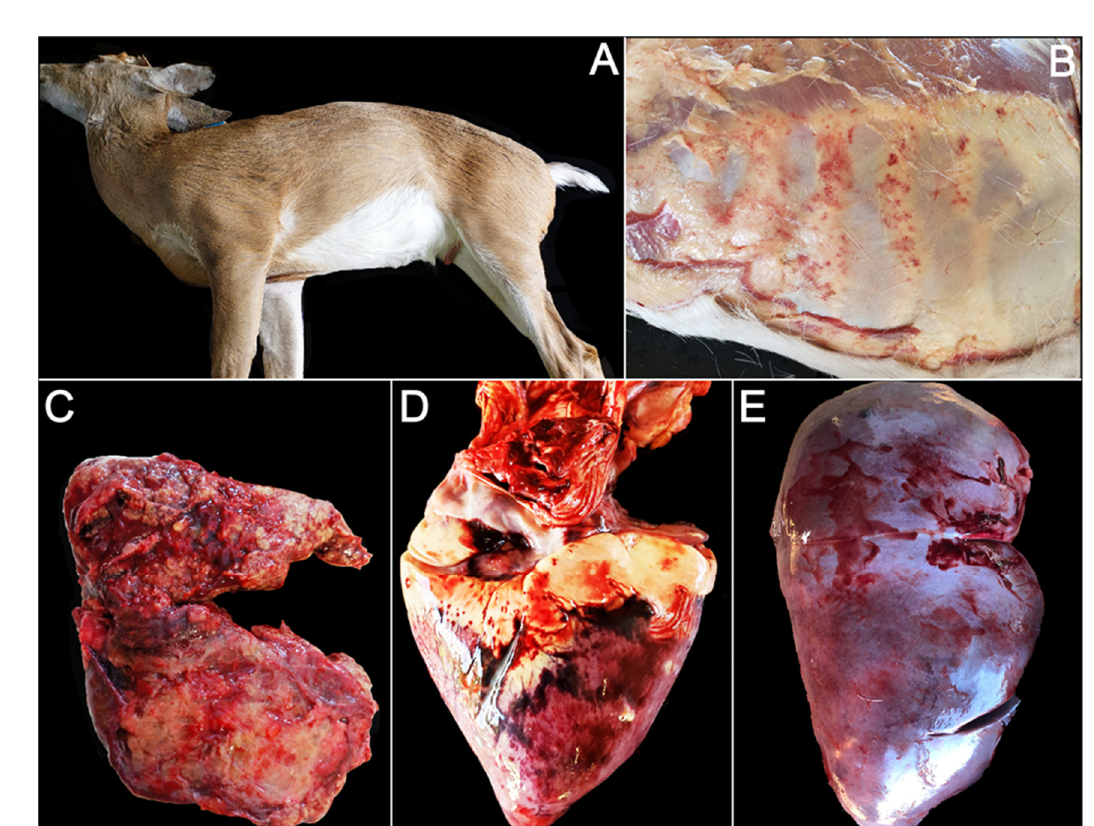
Figure 1. Gross photos of farmed white-tailed deer naturally infected with the U.S. novel reassortant EHDV-6 strain. ( A ) OV1296: swelling of the neck and jaw; ( B ) OV1300: diffuse, moderate petechiae of the thoracic and abdominal fascia; ( C ) OV1324: pulmonary hemorrhage with concurrent suppurative pneumonia; ( D ) OV1300: multifocal epicardial hemorrhage; ( E ) OV1265: hepatic congestion. Histopathology was performed on tissues from two animals (OV1248 and